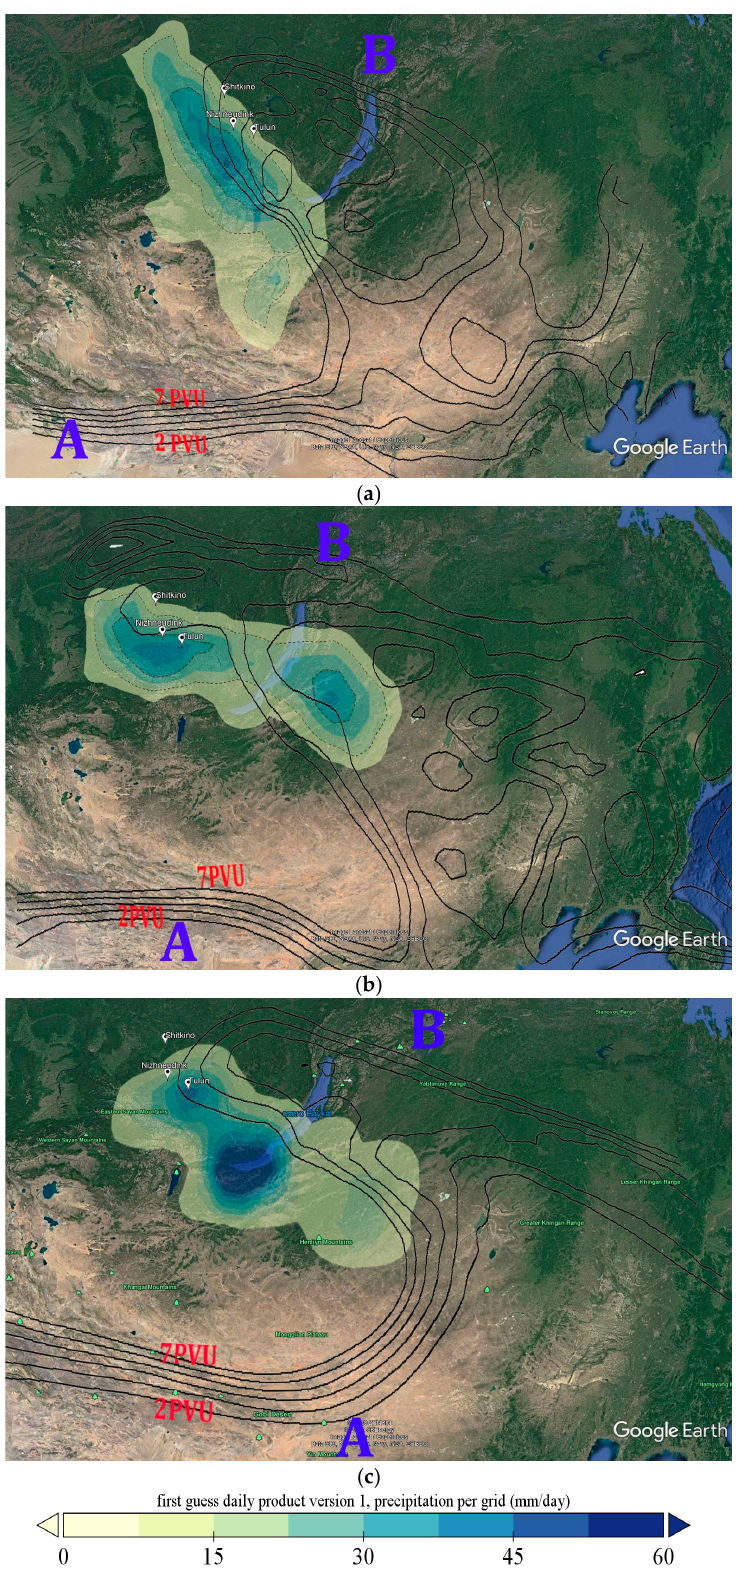
Figure 6. Goggle maps with the position of precipitation zone (total daily for 24 ( a ), 25 ( b ) June and 27 July ( c )) and PV overturning (2–7PVU) for 24 June 18 UTC ( a ), 25 June 12 UTC ( b ) and 27 July 12 UTC ( c ), letters A and B shows the schematic position of the start and end cross-section in Figure 7. Era-Interim